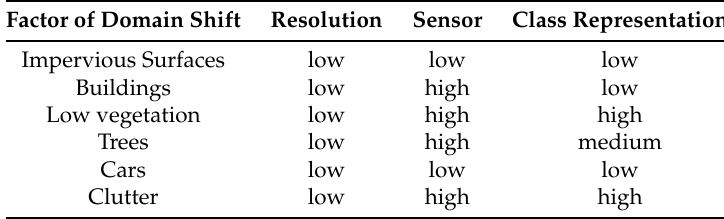
Table 2. Effect of the domain shift factors on every class when passing from the Potsdam dataset to the Vaihingen